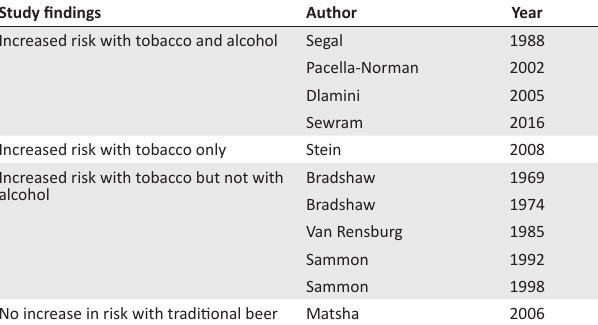
TABLE 2: Case control studies of tobacco and alcohol as risk factors for oesophageal cancer in South Africa.